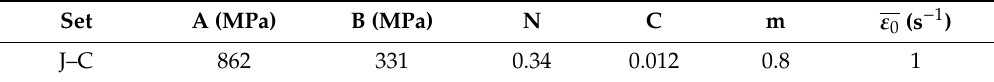
Table 2. J–C constitutive model parameters of Ti-6Al-4V, data from [28].